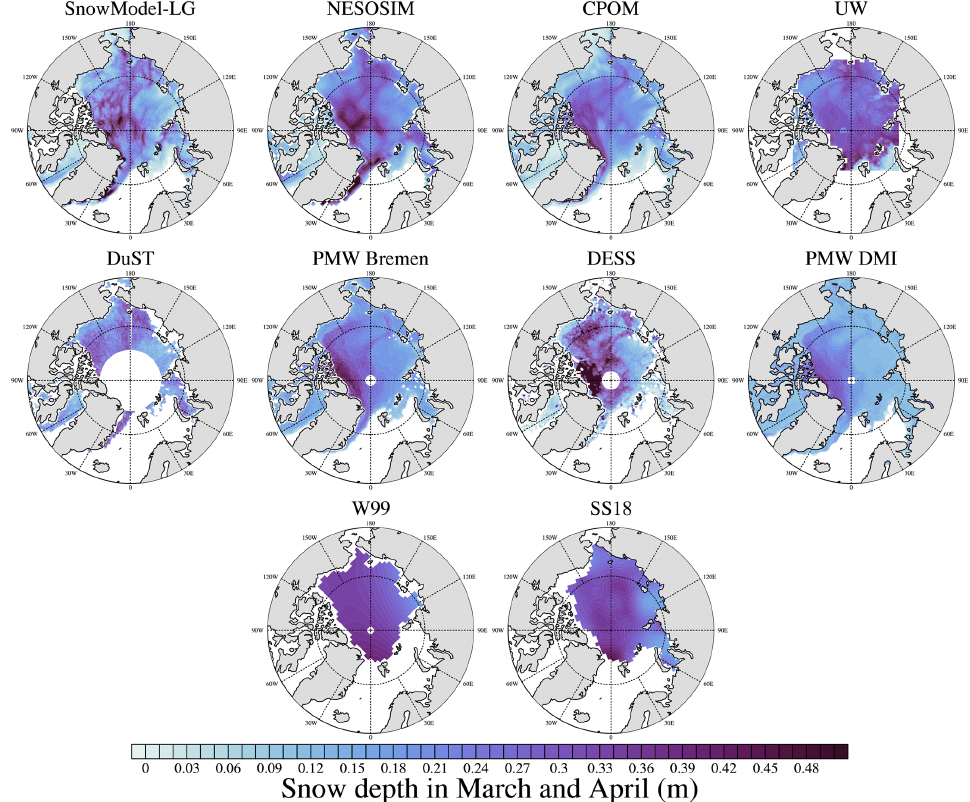
Figure 2. Mean snow depth (units: m) in spring (March–April) 2014 for eight snow products, W 99 and SS 18.